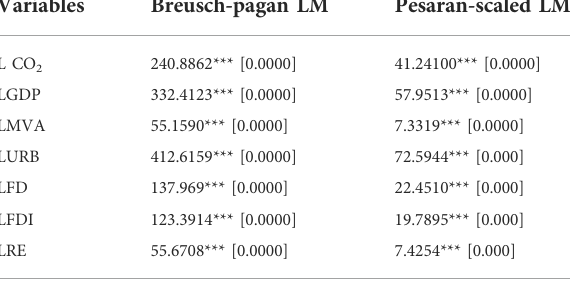
TABLE 3 Cross-sectional dependence (CD) tests.